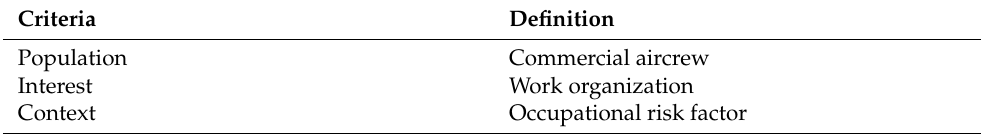
Table 1. PICO strategy for devising the research question.